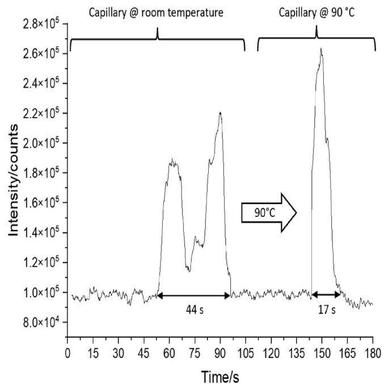
Comparison of the EI-MS signal width and peak form of 100 laser shots within 10 s on PMMA at room temperature and at 90 ◦C.